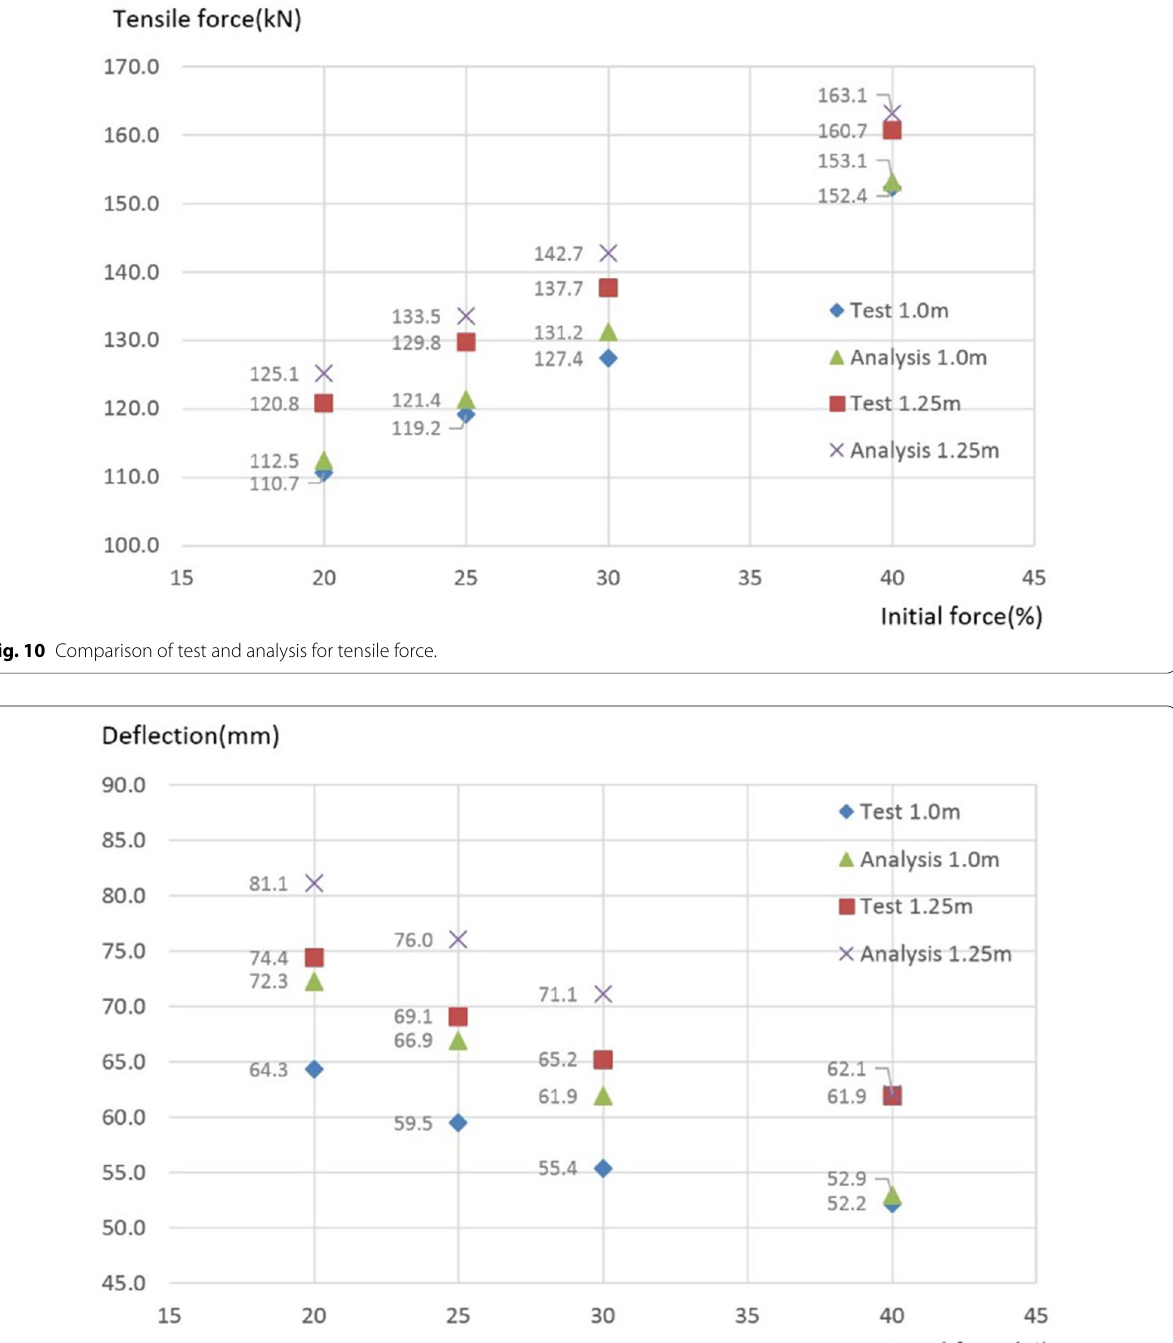
Fig. 11 Comparison of test and analysis for